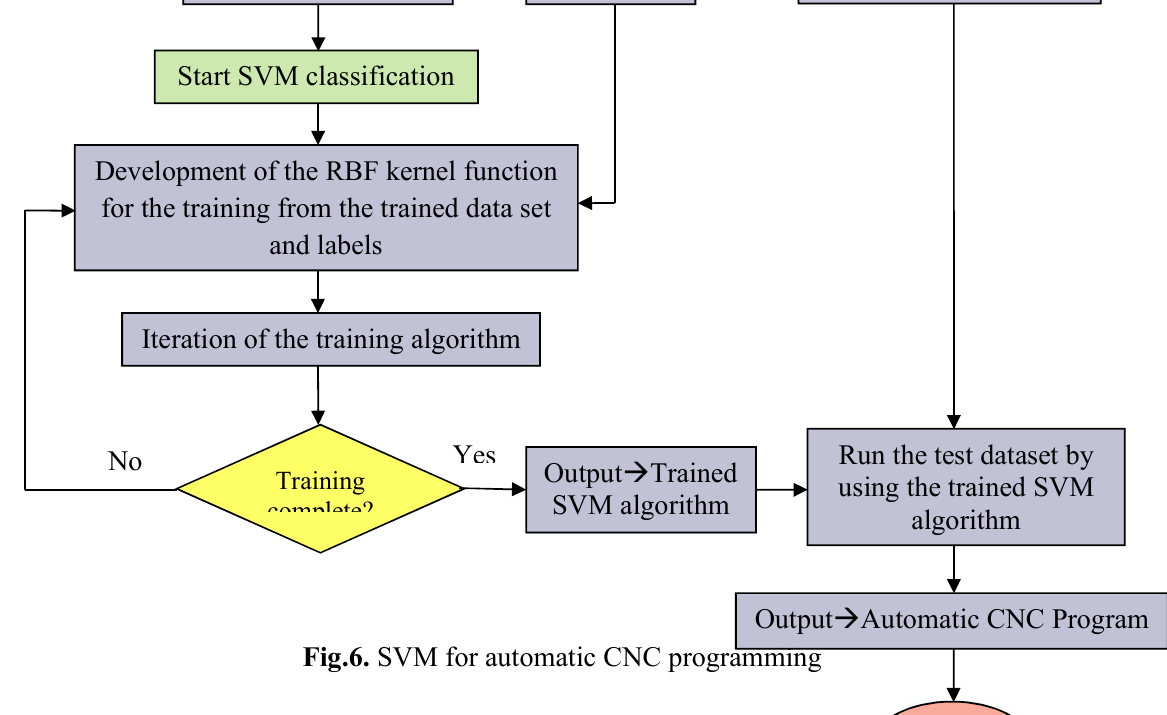
Training of data set Labelling Testing of the data set